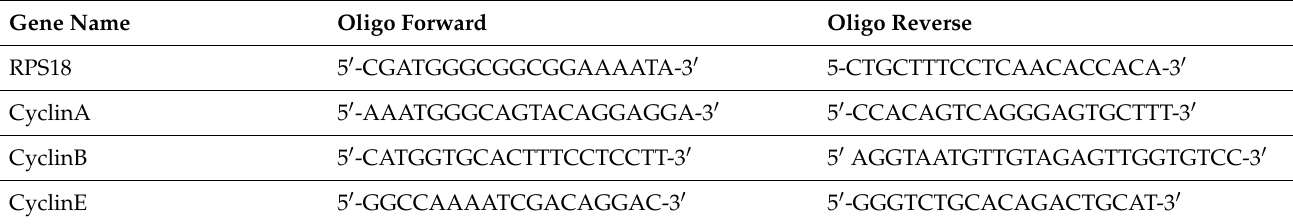
Table 1. Oligonucleotide sequences used for